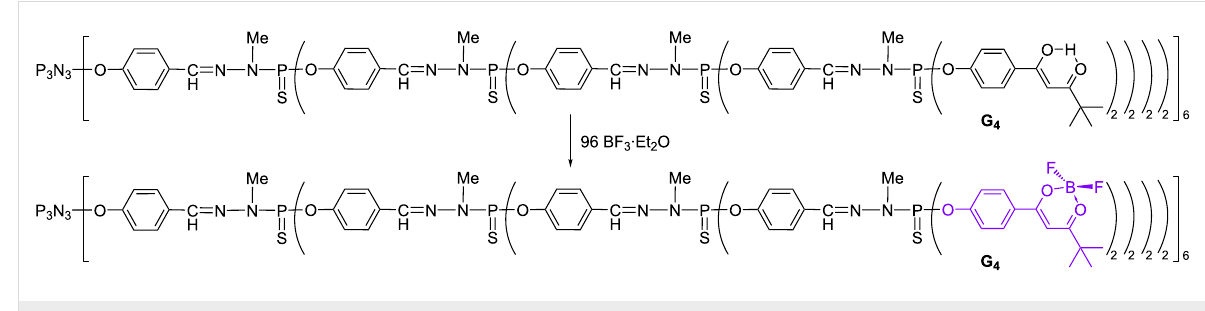
Scheme 3: Synthesis of the dioxaborine-functionalized dendrimer of generation